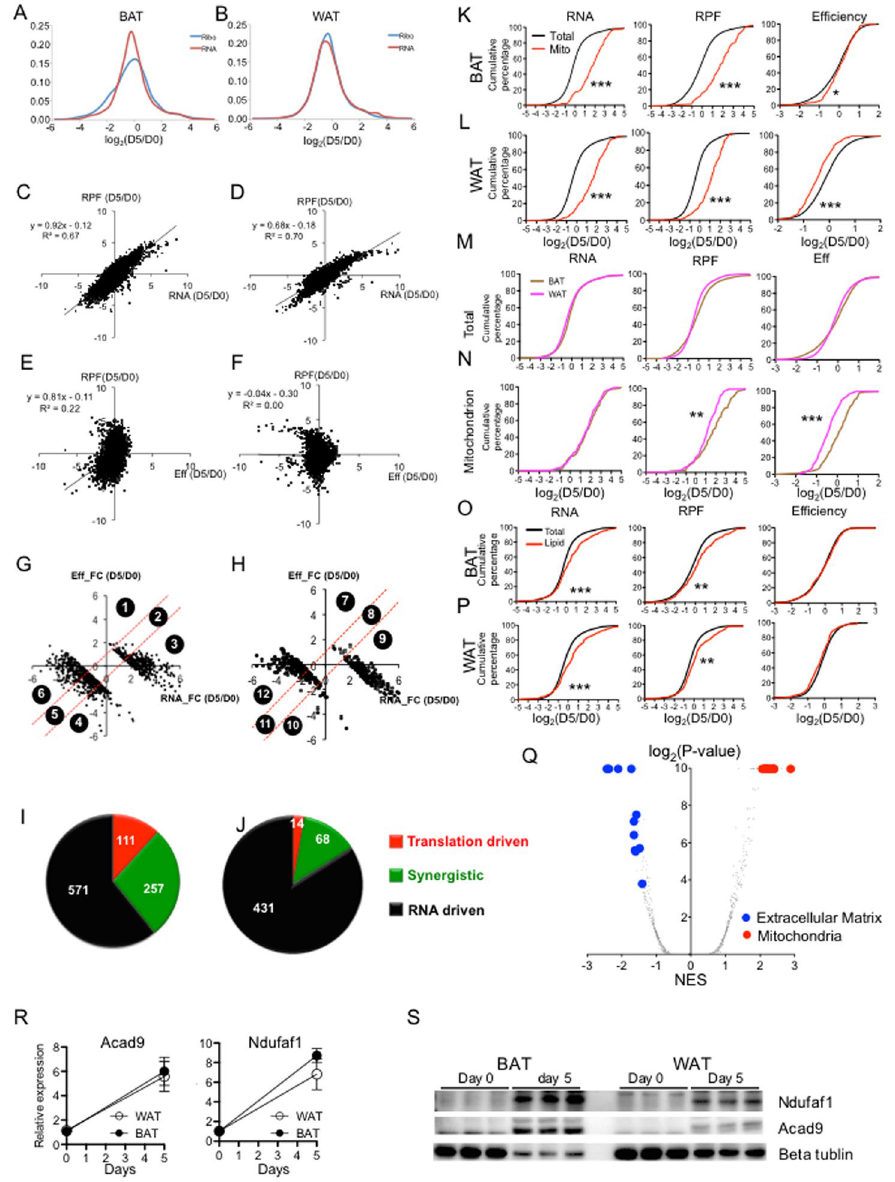
Figure 2. Genes encoding mitochondria components are more actively translated during brown adipogenesis than during white adipogenesis. ( A , B ) The distribution of RPF and RNA fold changes (FC) of each gene during ( A ) brown and ( B ) white adipocyte adipogenesis. ( C , D ) The correlation between RPF FCs and RNA FCs during ( C ) brown and ( D ) white adipogenesis. ( E , F ) The correlation between RPF FCs and translational efficiency (EFF) FCs during ( E ) brown and ( F ) white adipogenesis. ( G , H ) Based on the relative contribution of mRNA vs Eff FCs to the total translation FCs, 959 and 513 genes with ≥ 4 fold RPF changes in ( G ) brown and ( H ) white adipogenesis are classified into 6 groups. Genes with increased and decreased RFP comprise Group 1–3 and Group 4–6, respectively. ( I , J ) Pie charts to show the composition of each group during ( I ) brown and ( J ) white adipogenesis. Genes were classified into three types: translation driven, synergistic (driven by both RNA and translation), and RNA driven. ( K , L ) The cumulative fraction curves of (left) RNA-, (middle) RPF- and (right) Efficiency-FC during ( K ) brown and ( L ) white adipogenesis (D5/D0). The red line represents the genes related to mitochondria GO terms while the black line represents total detectable genes as the background. ( M , N ) The cumulative fraction curves of (left) RNA-, (middle) RPF- and (right) Efficiency FCs during adipogenesis for ( M ) all detectable genes and ( N ) genes related to mitochondrion GO. ( O , P ) As described in K and L. The red line represents the lipid metabolism related genes. * Represents P value < 0.05; ** represents P value < 0.01; *** represents P value < 0.001 (Kolmogorov–Smirnov test). ( Q ) Genes are ranked based on their difference between of Eff-FC in brown and in white adipogenesis. GSEA analysis was performed to derive the P values and normalized enrichment score (NES) for each pathway. Inverse volcano plot was generated using the -log 2 (P-value) vs. NES. ( R ) mRNA expression and ( S ) protein level of Acad9 and Ndufaf1 examined by real-time PCR and Western blot during brown and white adipogenesis. The Western image was cropped from a full gel picture (Fig. S6) N =